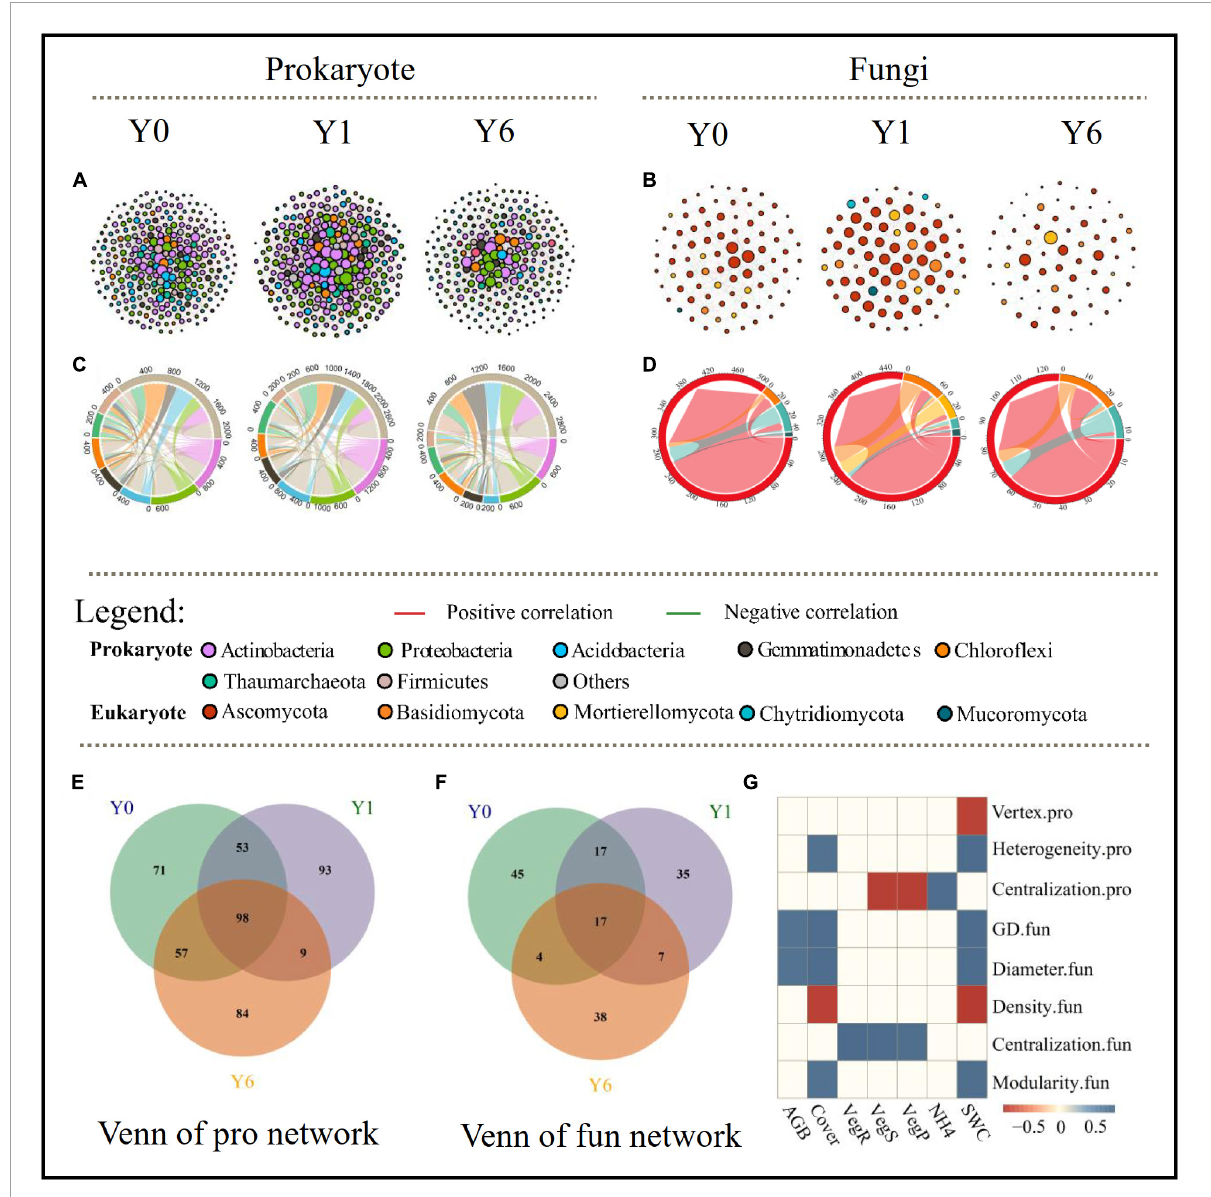
FIGURE3 Co-occurrence networks of soil prokaryotic and fungi communities (A,B) . Each point represents node (ASV) and each line (link) represents pairwise interaction between nodes, and node colors and size represent phyla and degree, respectively, red and green line indicate the positive and negative correlation between nodes, respectively. The chord diagram shows links among phyla in different network (C,D) . The chord color is identical with the nodes in networks. The chord width between two phyla is proportional to the number of associations. (E,F) represent venn graphs of nodes in prokaryotic networks and fungal networks, respectively. (G) represents the significant correlations between network features and environmental characteristics, network features with suffix “.pro” and “.fun” indicate prokaryotic and fungal networks features,